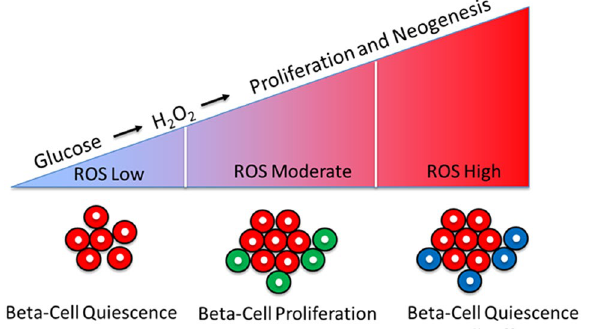
Figure 6. Model showing the role of different levels of H 2 O 2 in beta-cell proliferation and neogenesis. A regular supply of low levels of exogenous H 2 O 2 is necessary for beta-cell proliferation. Moderate levels of H 2 O 2 drive beta- cell proliferation, whereas high levels of H 2 O 2 induce beta-cell quiescence and stimulate neogenesis of beta-cells. Our model suggests that in a physiological context, such as nutrient-stimulation, H 2 O 2 is produced by the beta- cell in response to glucose and plays a role as a second-messenger responsible for driving beta-cell